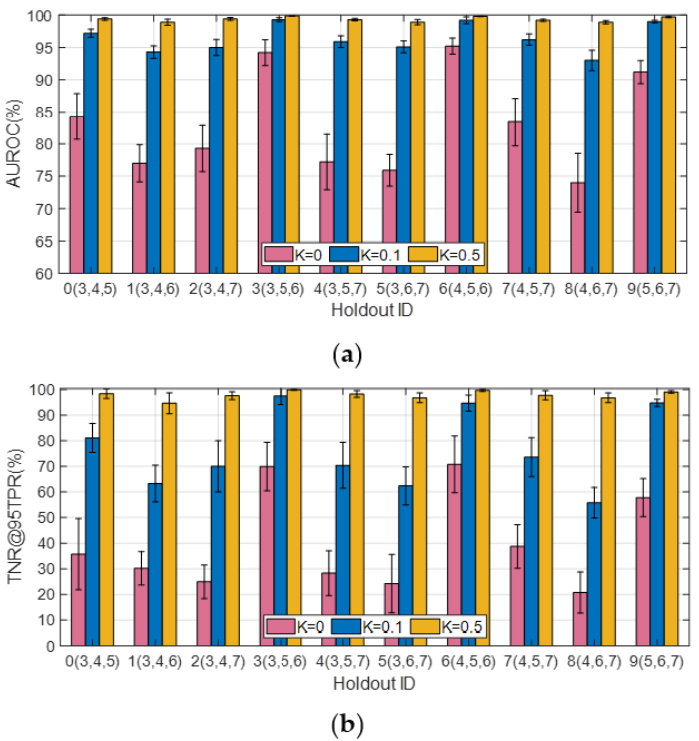
Figure 13. Effect of K on AUROC and TNR@95TPR ( J = 3). ( a ) AUROC; ( b ) TNR@95TPR.